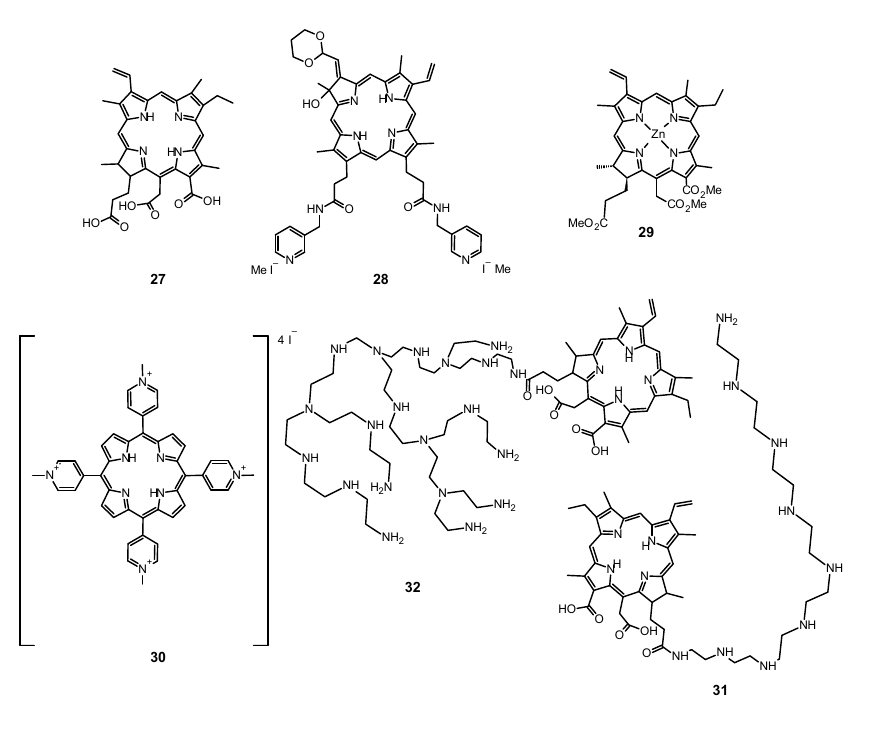
Figure 8. Structures of chlorins ( 27–32 ). Sueoka et al. investigated cationic chlorin derivative TONS 504 ( 28 , Figure 8) excited with LED (660 nm) against Fusarium solani and Aspergillus fumigatus [215]. Concentration of 1 mg/L and LED irradiation at the dose of 30 J/cm 2 or 10 mg/L and light dose of 10 J/cm 2 was enough for complete elimination of F. solani , whereas A. fumigatus was more resistant. It was possible to achieve a significant but not complete reduction but a higher concentration and a light dose (10 mg/L; 30 J/cm 2 ) were required [215]. Carvalho et al. observed biofilm formation inhibition using 27 [216]. Biofilm growth was reduced about 90% using 20 µ M PS and LED light (660 nm) at the dose of 40 J/cm 2 . Its effectiveness is due to an increasement of the cell membrane permeability after PACT, about 5 times compared to control [216]. Diogo et al. compared the PACT activity of Zn (II) chlorin e6 methyl ester ( 29 , Figure 8) and other PSs ( 3 , 10 , tetracationic porphyrin— 30 ) as well as conventional agents (3% NaOCl, 17% EDTA and 2% chlorhexidine gluconate—CHX) against E. faecalis and C. albicans mono and multispecies biofilms. 27 and tetracationic porphyrin activated with light showed the highest reduction rate in biofilm among PSs studied. Noticed activity was similar to that obtained for CHX and EDTA; 29 coupled with red LED light (627 nm) removed 58.98% of dual-species biofilm. NaOCl showed the highest antimicrobial effectiveness, but its disadvantage is high cytotoxicity [217]. In order to improve 27 photodynamic activity, Yang et al. encapsuled the PS in positive charged liposomes composed of cetyltrimethyl ammonium bromide (CTAB) and dimyristoyl- sn - glycero-phosphatidylcholine [218]. Encapsulation prevents aggregation of PS, which leads to the decreasing of singlet oxygen formation. Moreover, the positive charges increase the affinity for the negatively charged wall of C. albicans . Increasing the ratio of CTAB to lipids leads to an increase in the zeta potential and increases binding to the yeast. At a low lipid:CTAB ratio (10:1), no significant difference in inactivation was noticed between not bound 27 and that placed in liposomes. However, total elimination of C. albicans was achieved with a lipid:CTAB ratio of 10:3 and 27 a concentration of 10 µ M. The higher CTAB amount resulted in increase of reductions of C. albicans growth (up to 6 log). It was pointed out that the efficacy of PACT is also dependent on particle size and PS concentration. It was found that PS loaded into smaller liposomes, (80 nm in comparison to 117 nm), showed much higher photodynamic antimicrobial activity. The use of liposomes